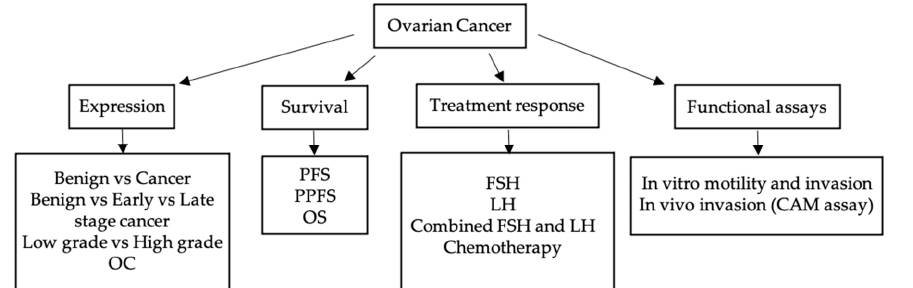
Figure 1. Workflow diagram of this study showing analysis performed for investigating expression differences and effects of the piRNA pathway genes in multiple aspects of OC.